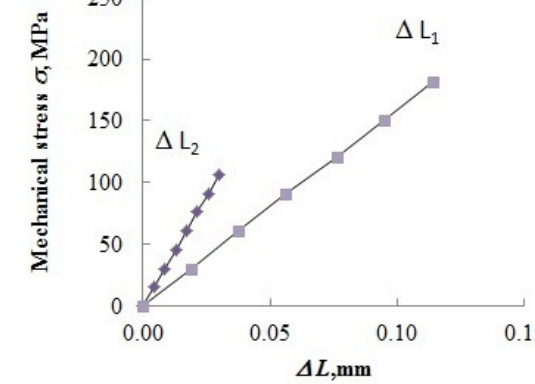
Figure 4. The change in the absolute elongation under the action of mechanical stresses in the pressure